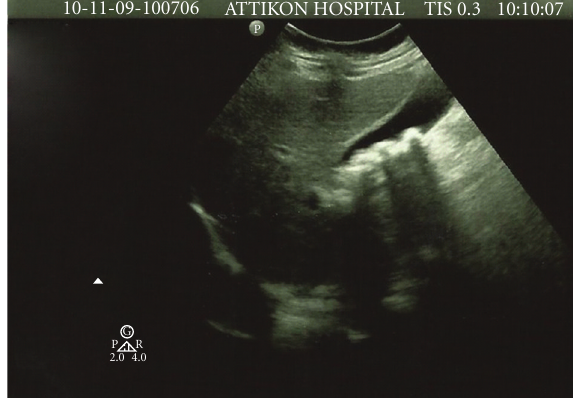
Figure 1: Sonogram in one of our patients showing multiple echogenic material with acoustic